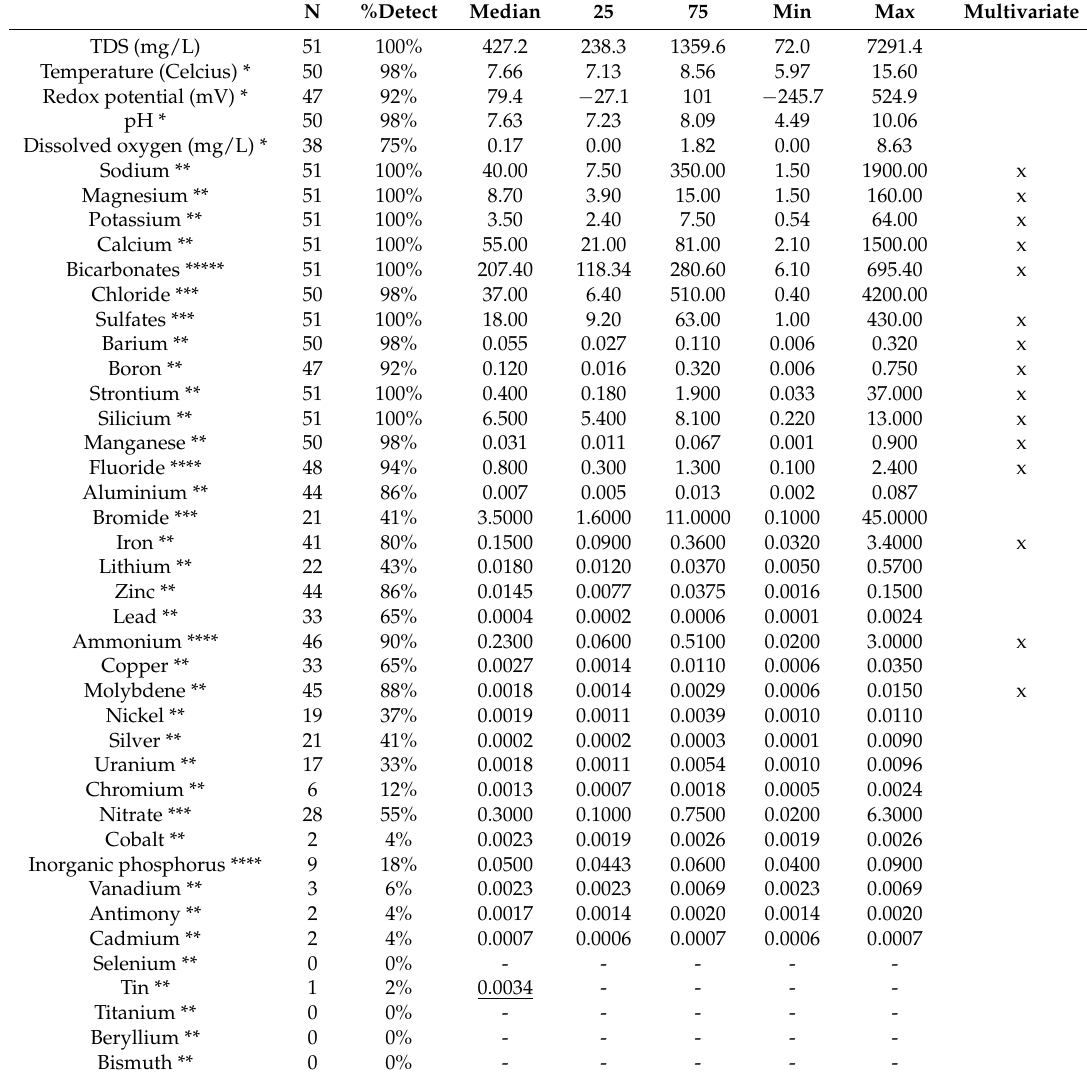
Table 3. Statistical data for the 51 sample